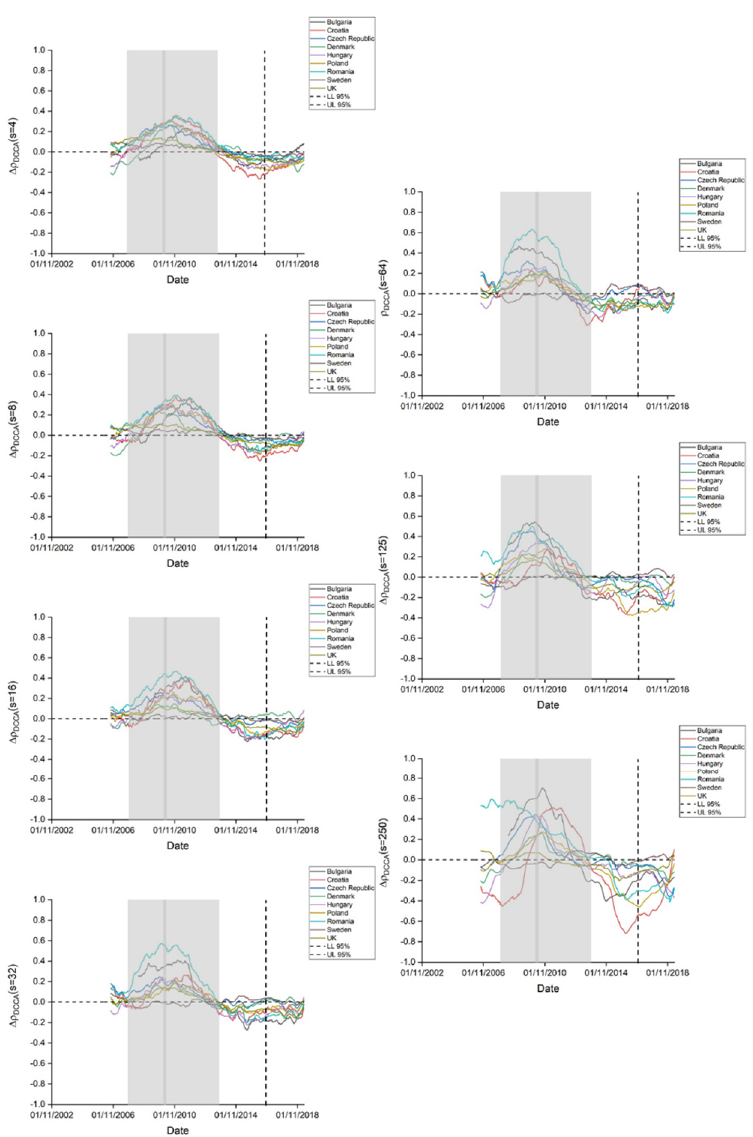
Figure A6. Evolution of the ∆ ρ DCCA between non-Eurozone stock markets and Germany for time scales of 4, 8, 16, 32, 64, 125, and 250 days, considering that ∆ ρ DCCA ( 1 ) = ρ DCCA ( 1001 ) − ρ DCCA ( 1 ) . LL and UL are, respectively, the lower and upper limits of the confidence interval. Shaded areas represent the global financial crisis and the Eurozone debt crisis. The vertical dashed line refers to the moment of the Brexit referendum.